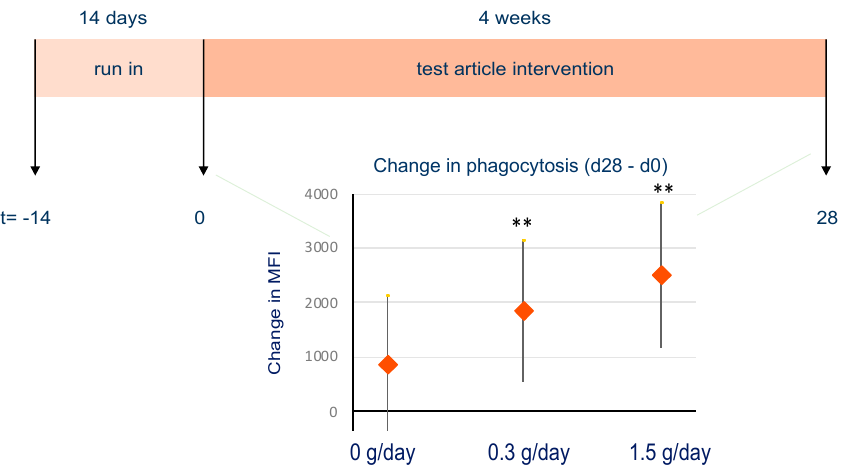
Figure 7. Phagocytic activity of granulocytes as the change on day 28 versus baseline of the median fluorescent intensity. ** p < 0.01.